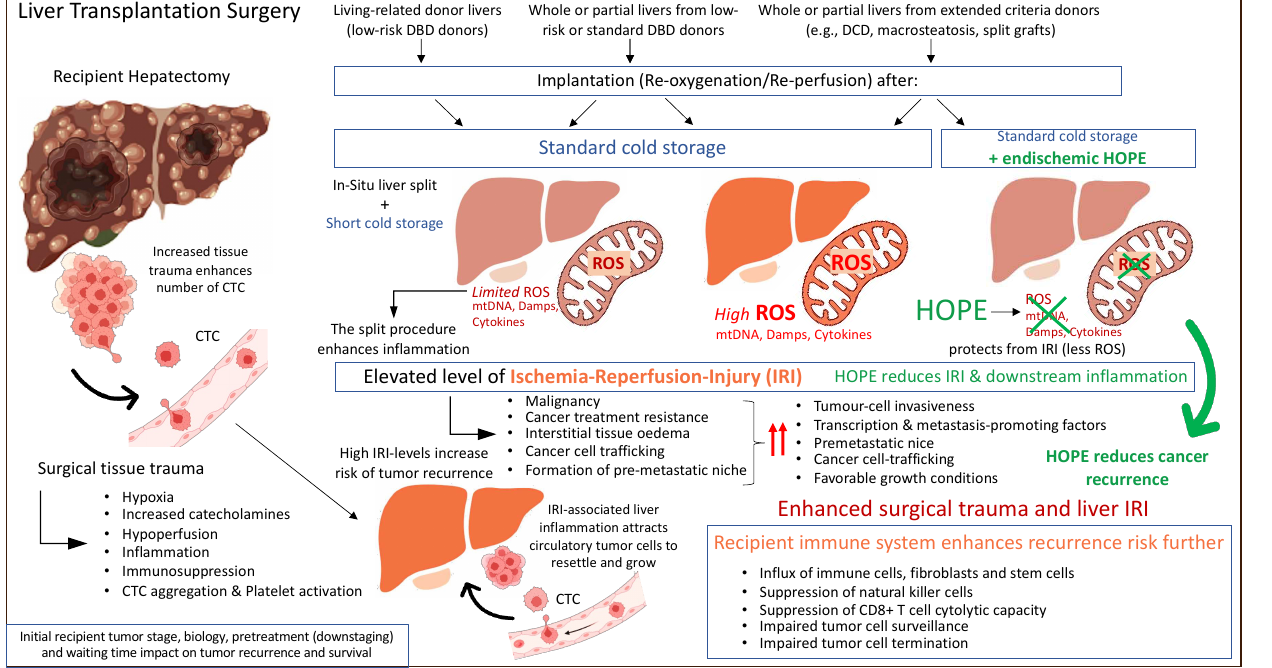
Figure 4. Peri-transplant events with an impact on residual cancer cells and tumor recurrence after liver transplantation. CTC: circulating tumor cells; Damps: danger associated molecular pattern; DBD: donation after brain death; DCD: donation after circulatory death; HOPE: hypothermic oxygenated perfusion; ROS: reactive oxygen species. This figure was designed with the support from biorender.com (accessed on 15 June 2022).